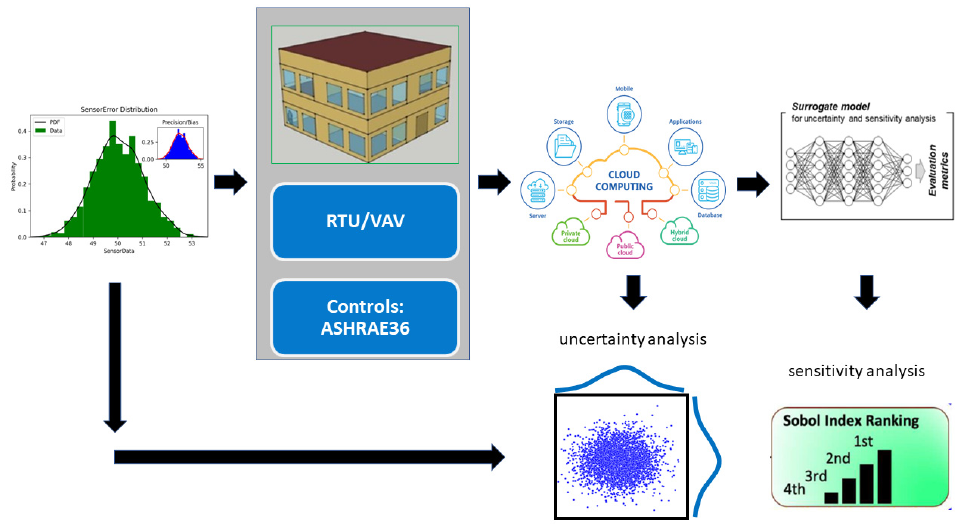
Figure 1. Sensor impact and evaluation framework.